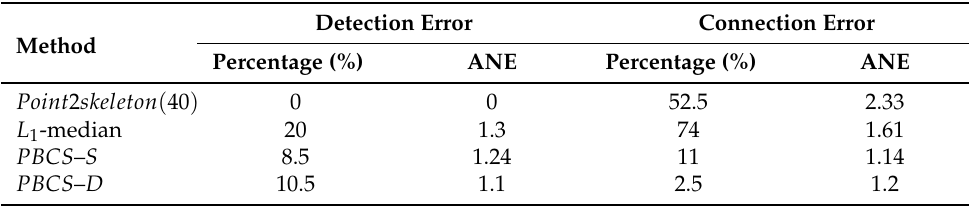
Table 3. Results of the comparison between the L 1 -median skeleton approach and our curve skeleton extraction method. The percentage represents the percentage of data with errors out of the total data. ANE stands for the average number of errors per erroneous data